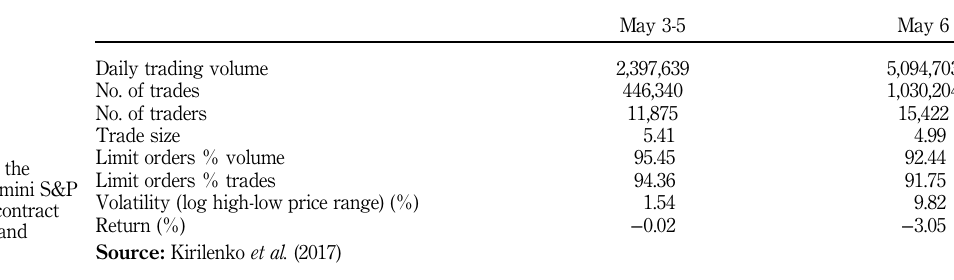
Table I tabulates summary of statistics for the June 2010 E-mini S&P 500 futures contract for May 3-5 and May 6, 2010 (Kirilenko et al. , 2017). Similarly, Figure 2 presents minute-by- minute transaction prices and trading volume of the June 2010 E-mini S&P futures contract on May 6, 2010 between 8:30 and 15:15 CT. Trading volume is calculated as the number of contracts traded during each minute. Transaction price is the last transaction price of each